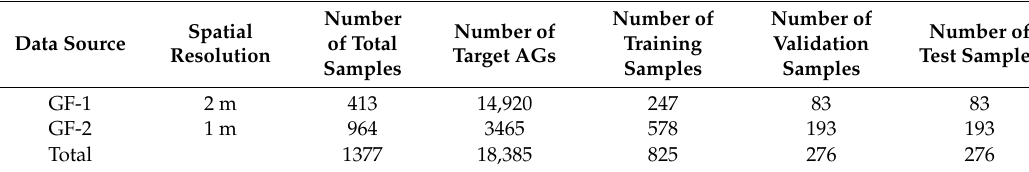
Table 1. The dataset of samples.